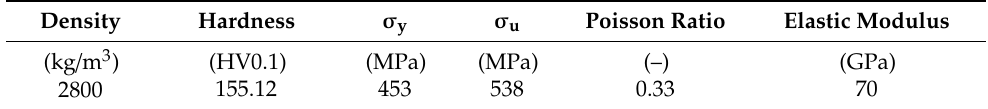
Table 2. Main mechanical properties of aluminum alloy